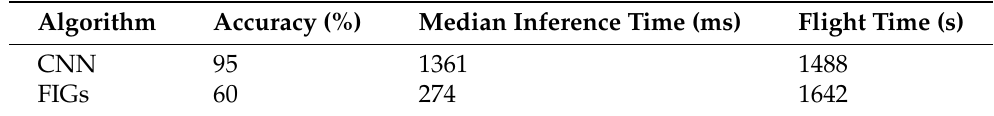
Table 3. ML algorithm accuracy vs. performance for on-board inference.